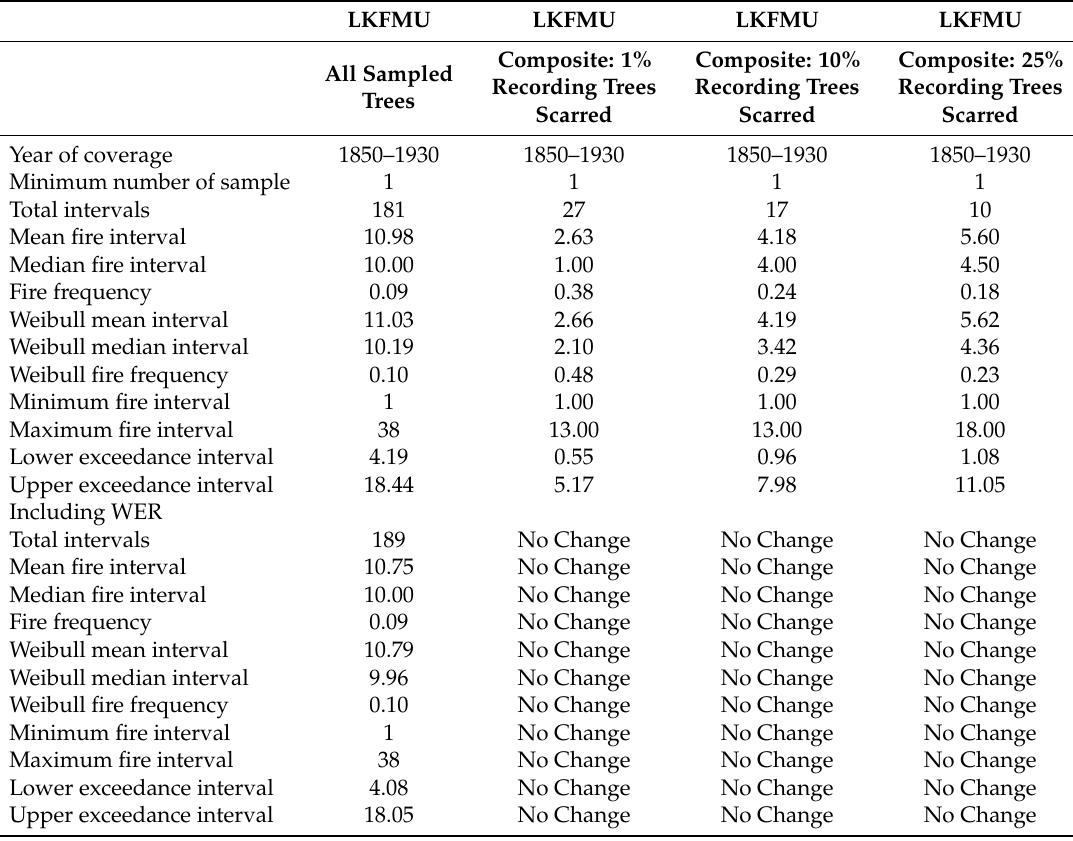
Table 1. Descriptive statistics and fire intervals for Lake Katherine Fire Management Unit in Riding Mountain National